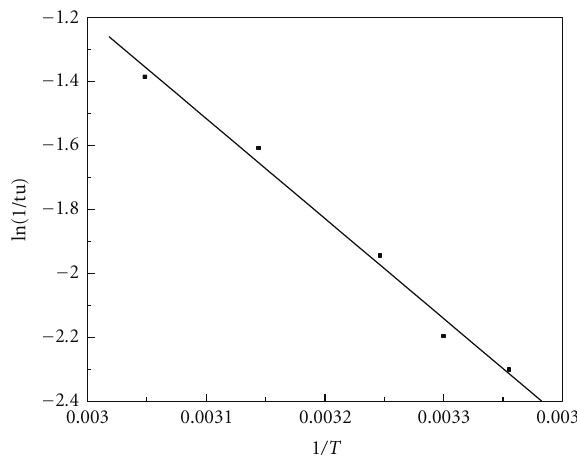
Figure 12: FTIR spectrum of intermediate 1. enol isomer of keto-enol tautomerism. In the FTIR spectrum